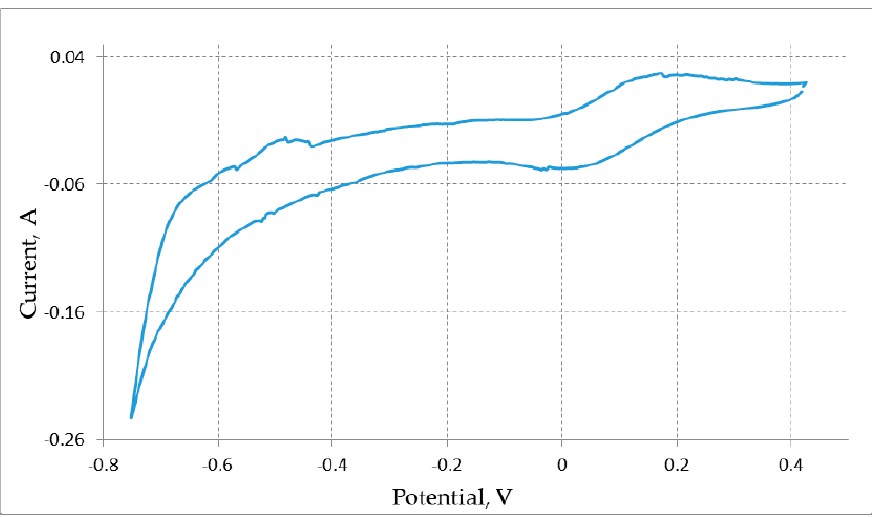
Figure 3. Cyclic voltammograms of the UO 2 + (CeO 2 + La 2 O 3 + Nd 2 O 3 ) 5 wt.% pellet located on the Mo electrode recorded in the LiCl—Li 2 O (1.0 wt.%) melt at 650 ° С . The scan rate was 0.01 V/s; the Bi-Li reference electrode (0.700 V relative to Li + /Li) was used.